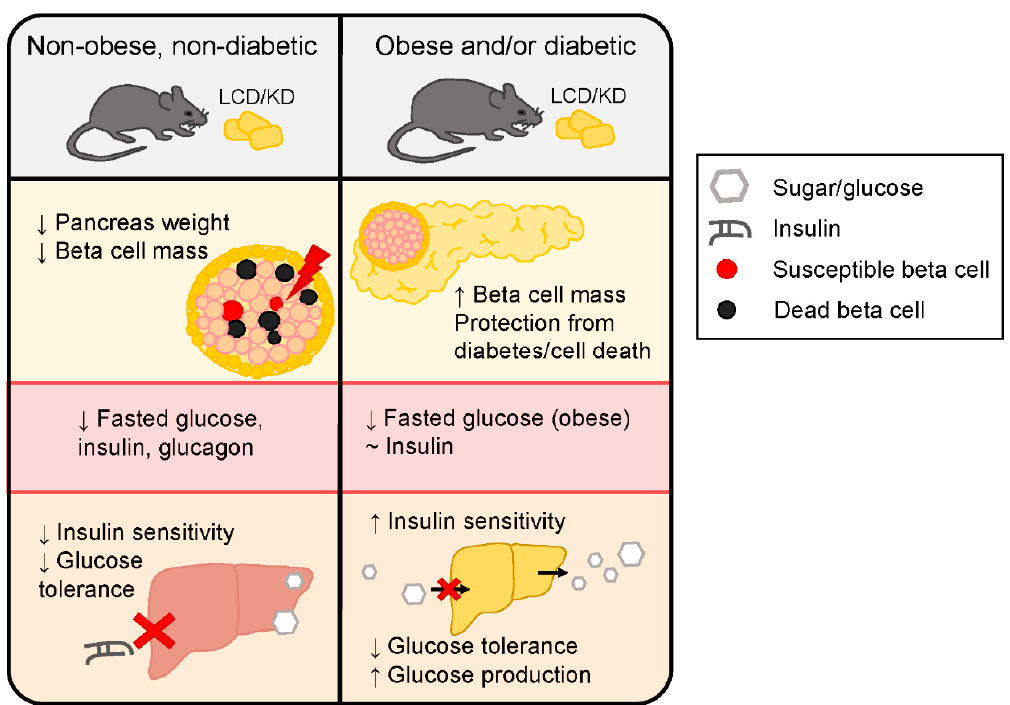
Figure 1. Extreme carbohydrate-restricted diets may confer some benefits in obese and diabetic rodents compared to healthy rodents. Some reports of ketogenic diet (KD) and carbohydrate-free diets (CFDs) demonstrate protection against the onset of diabetes with improved beta cell survival or proliferation after streptozotocin treatment. Low-carbohydrate diets (LCDs) improve fasted and random glycemia but worsen insulin responsivity during hyperinsulinemic euglycemia clamp studies and increase glycemia during glucose tolerance tests.